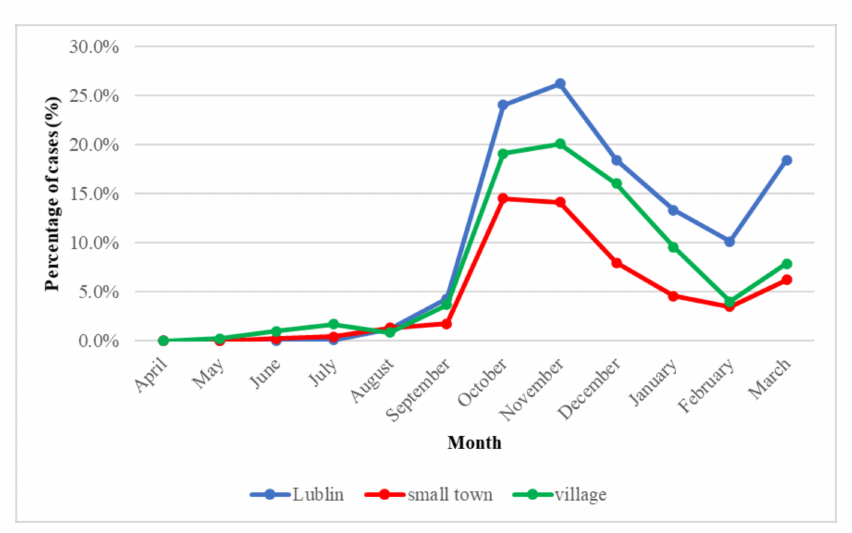
Figure 2. SARS CoV-2 infection from April 2020 to March 2021 in south-eastern Poland by place of residence.